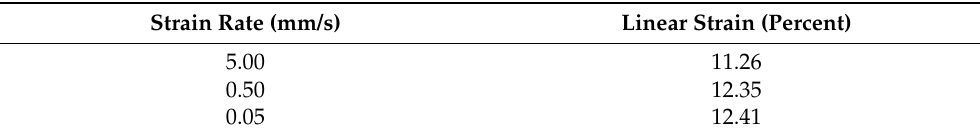
Table 1. The average yield strain from sensors pulled at 5.0 mm/s, 0.5 mm/s, and 0.05 mm/s. Note that the linear strain range of the stress–strain diagram was not significantly affected by strain